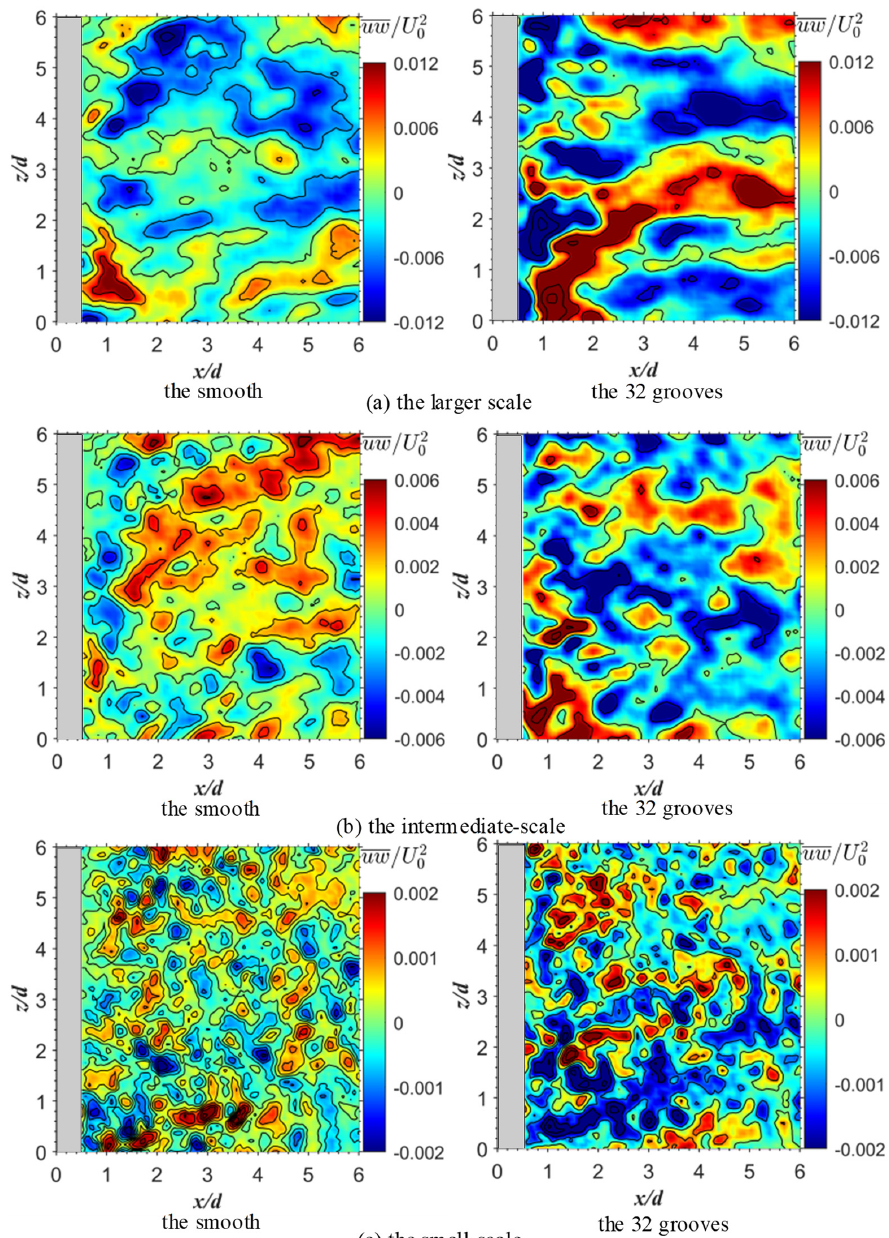
Figure 17. Multi-scale shear stress distributions of the smooth and 32-groove cylinders in the ( x, y )-plane.